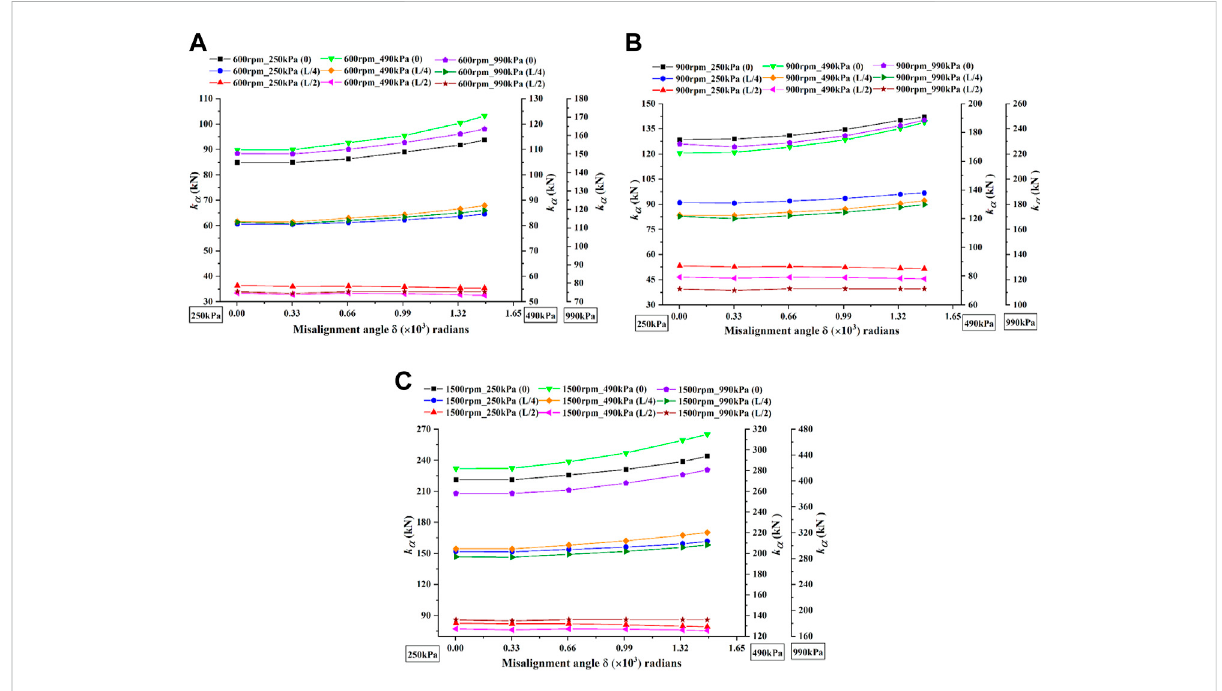
FIGURE 12 The variations of cross-coupled stiffness coef fi cients with misalignment angle under different pressure differences and rotational speeds. (A) 600rpm. (B) 900rpm. (C)